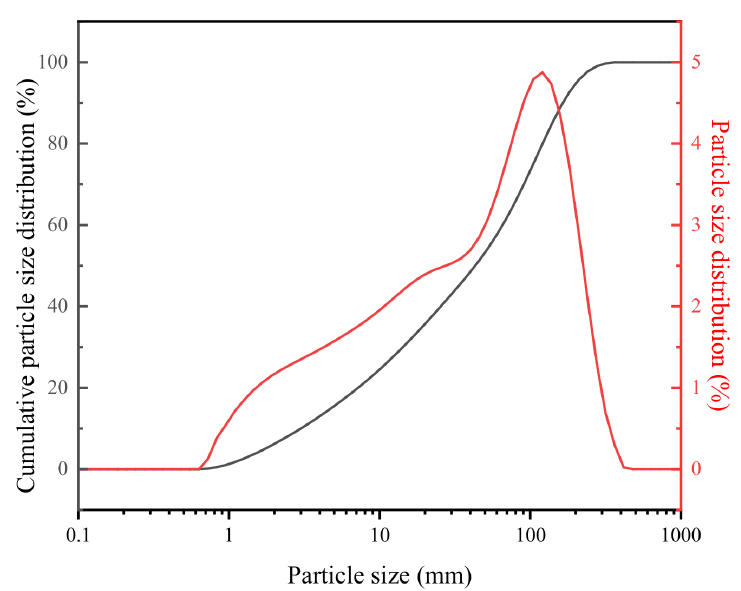
Figure 3. Particle size gradation curve of RCP.